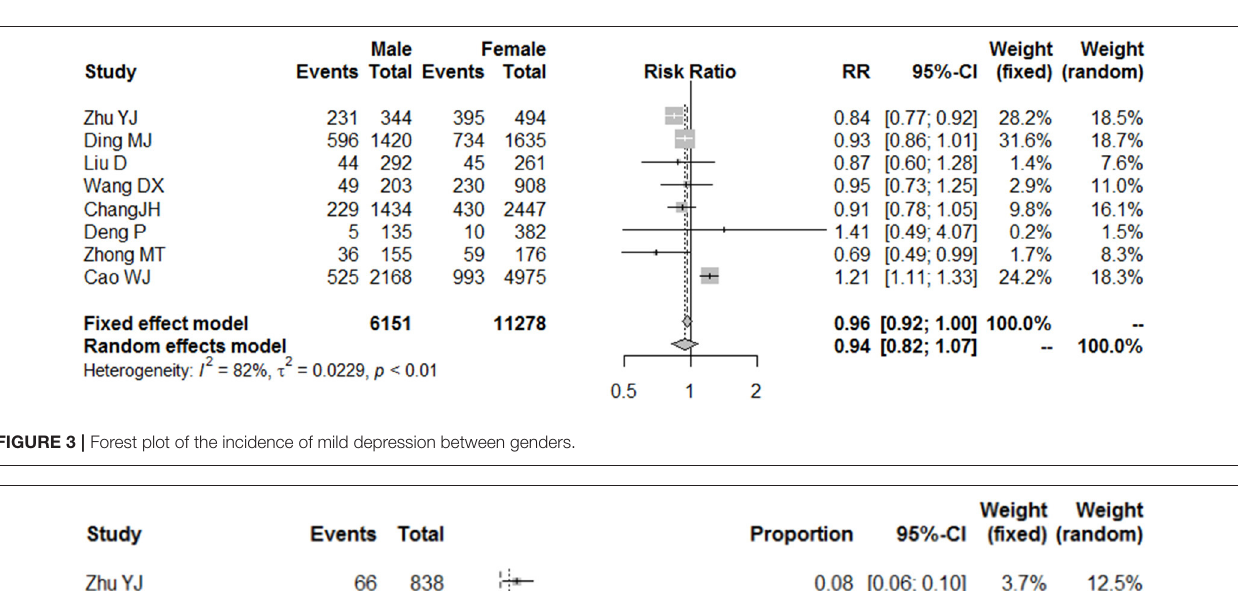
FIGURE 2 | Forest plot of the incidence of mild depression among college students during COVID-19.